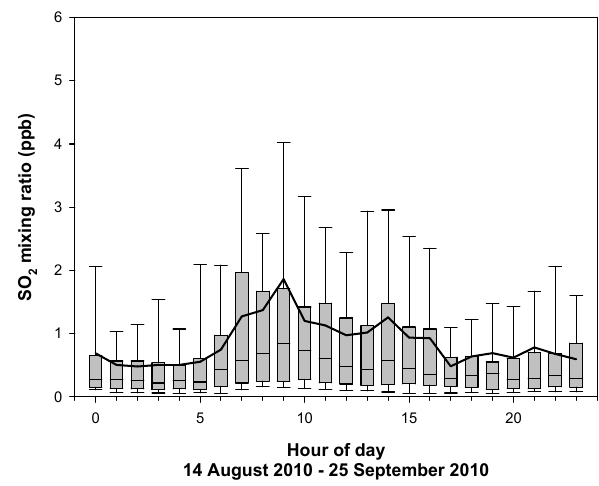
Fig. 11. The diurnal profile of SO 2 mixing ratios during the summer of 2010.